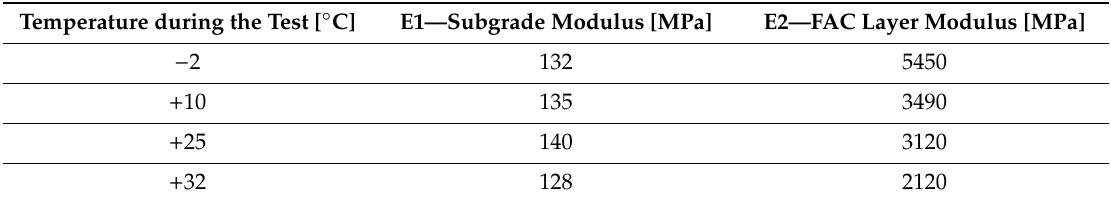
Table 6. List of identified module